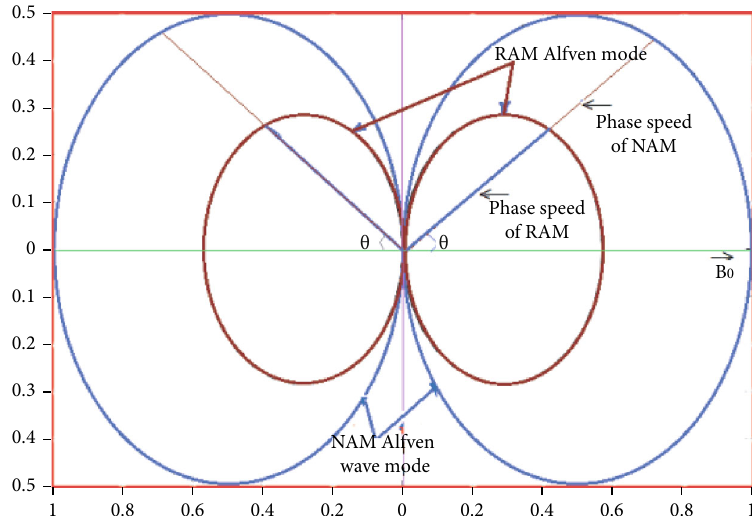
Figure 1: Polar plots of the phase speeds of Alfve ′ n mode for RAM and nonrelativistic anisotropic magnetohydrodynamics (NAM) two component plasma using M 2 A = 0 : 9, b 2 ⊥